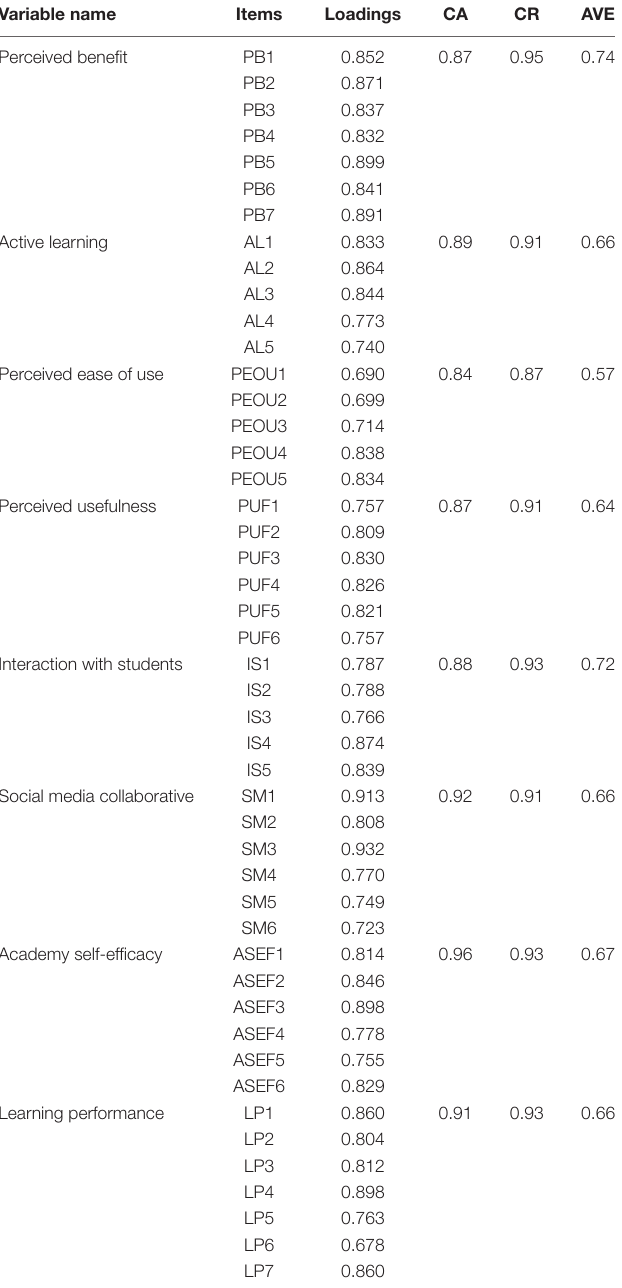
TABLE 4 | Results of confirmatory factor